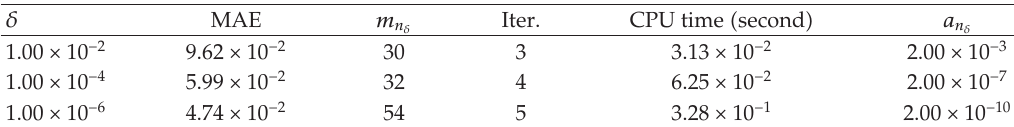
Figure 1: Example 3.1: the stability of the approximate solution. Table 1: Example